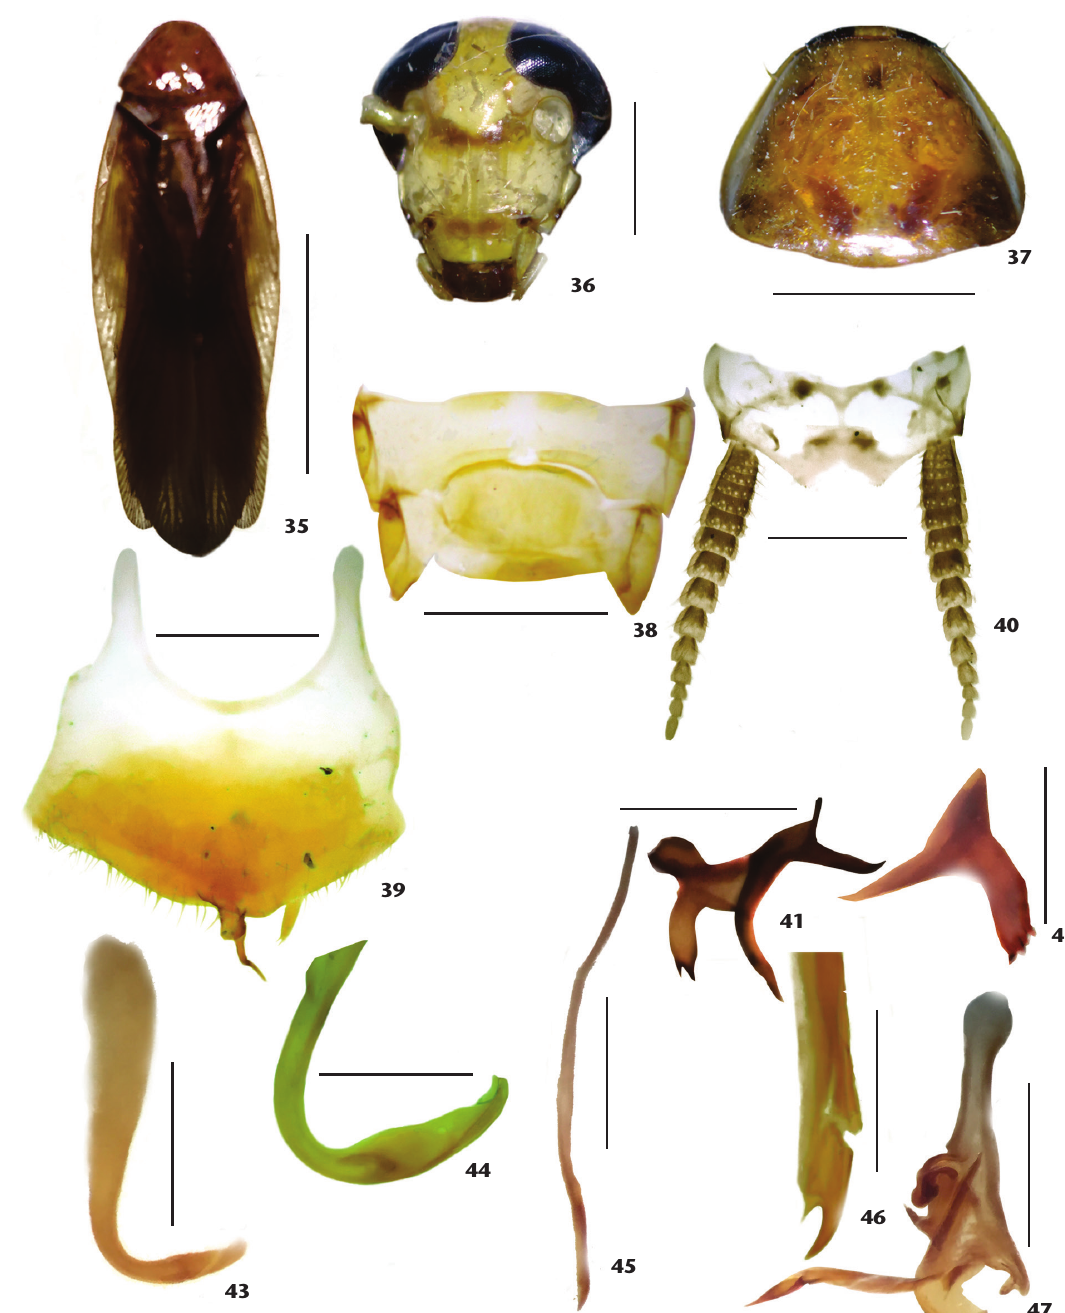
9Figures 35-47. Xestoblatta vera , paratype male: (35) habitus, dorsal view, length 22.4 mm; (36) head, ventral view; (37) Pronotum, dorsal view; (38) Tergal modification of the tergite VII, dorsal view; (39) Subgenital plate, ventral view; (40) Supra anal plate, dorsal view; (41) Left paraproct, dorsal view; (42) Right paraproct, dorsal view; (43) Left phallomere (L3), dorsal view; (44) Apex of left phallomere, dorsal view; (45) median esclerite (L2vm), dorsal view; (46) Apex of mediam sclerite, Scale Bar:0,4mm; (47) Right phallomere (R2), dorsal view. Scale bars: 36 = 1.5 mm, 37 = 3.5 mm, 38 = 3.0, 39 = 1.3 mm, 40 = 1.5 mm, 41, 45, 47 = 1.0 mm, 42 = 0.5 mm, 43 = 0.5 mm, 44 = 0.3 mm, 46 = 0.4 ZOOLOGIA 33(6): e20160041 | DOI: 10.1590/S1984-4689zool-20160041 | December 15, 2016 7 /